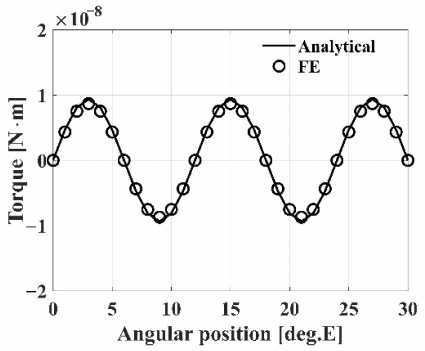
Figure 5. Cogging torque according to the rotor